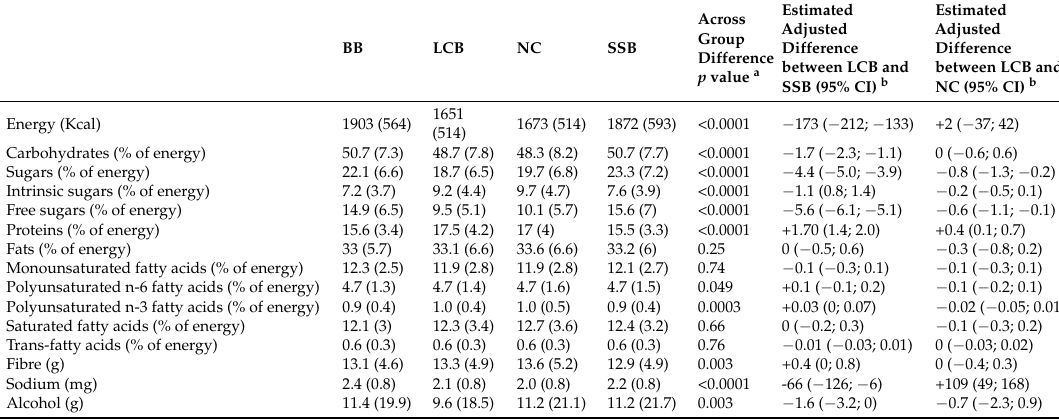
Table 2. Energy and nutrients intake according to type of beverage consumption.